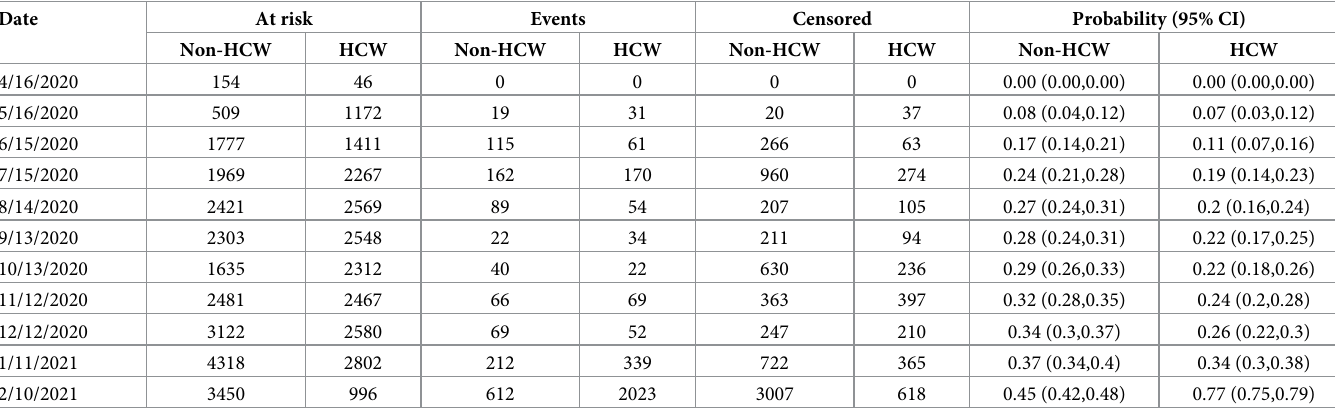
Table 3. Cumulative probability of seroconverting over